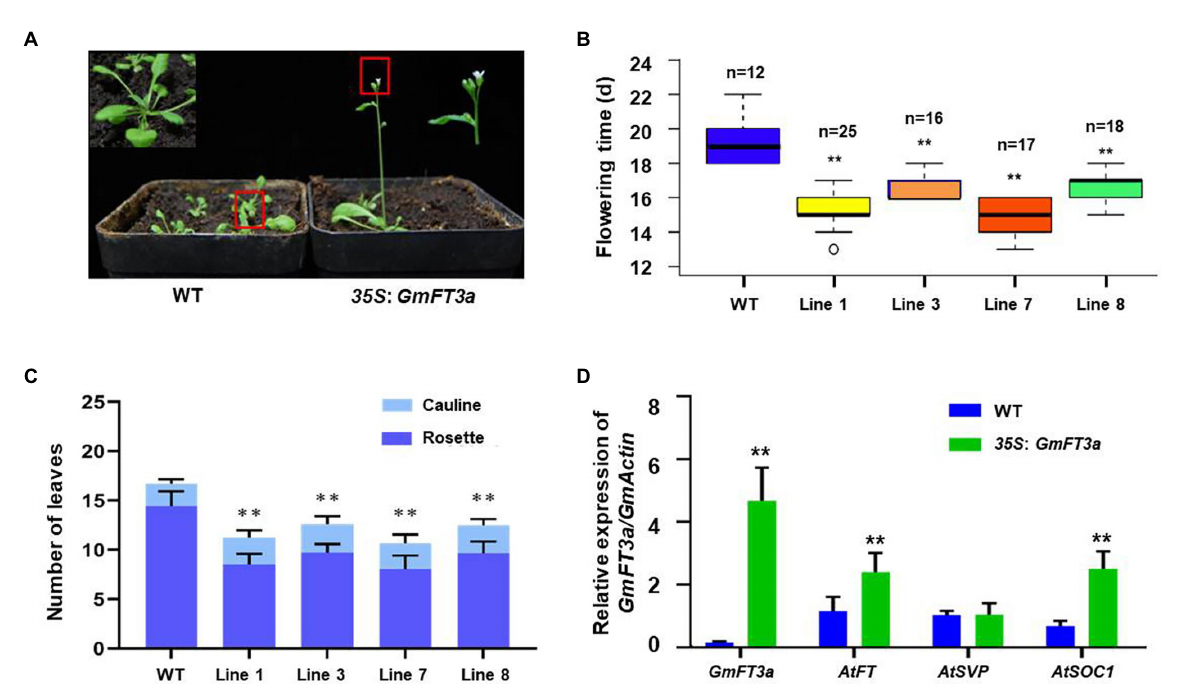
FIGURE 2 The phenotype (A) , flowering time (B) , the number of rosette and cauline rosette leaves at flowering (C) and the expression of flowering regulatory genes (D) of the transgenic GmFT3a lines under LD condition in